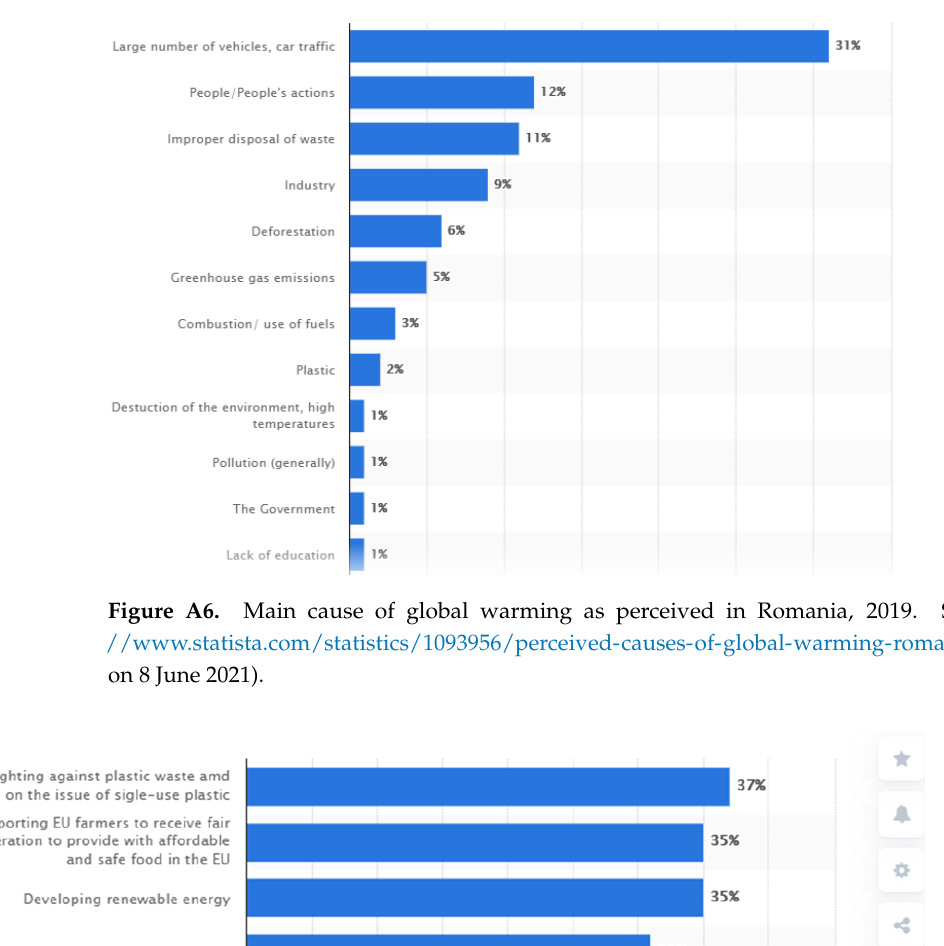
Figure A7. Romania: public opinion on the objectives in a European Green Deal 2019. Source: https://www.statista.com/statistics/1110123/european-green-deal-objectives-romania/ (accessed on 8 June 2021).